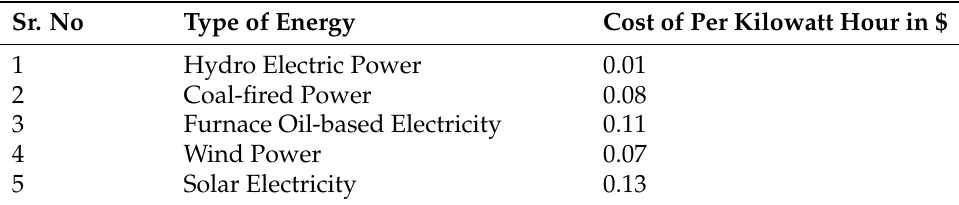
Table 5. Cost comparison of hydro energy with other energy sources